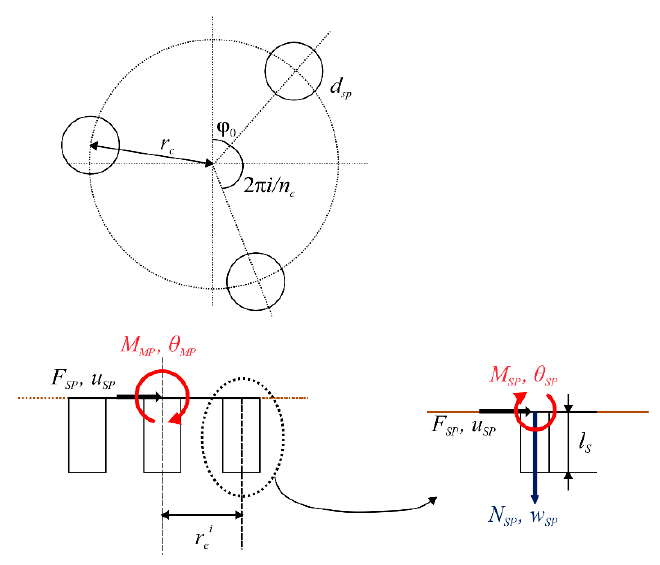
Figure 10. Schematic diagram of multisuction piles.